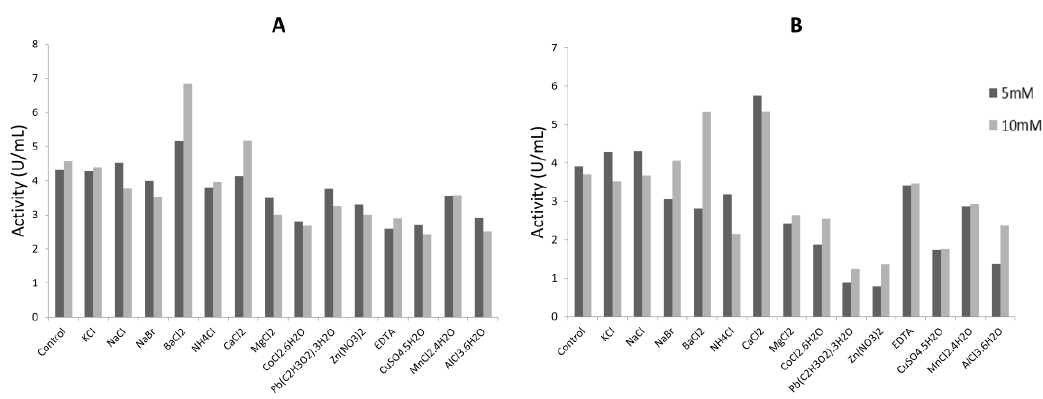
Figure 6. Effect of ions on lipases activity ( A ) Lip1 e ( B ) Lip2.